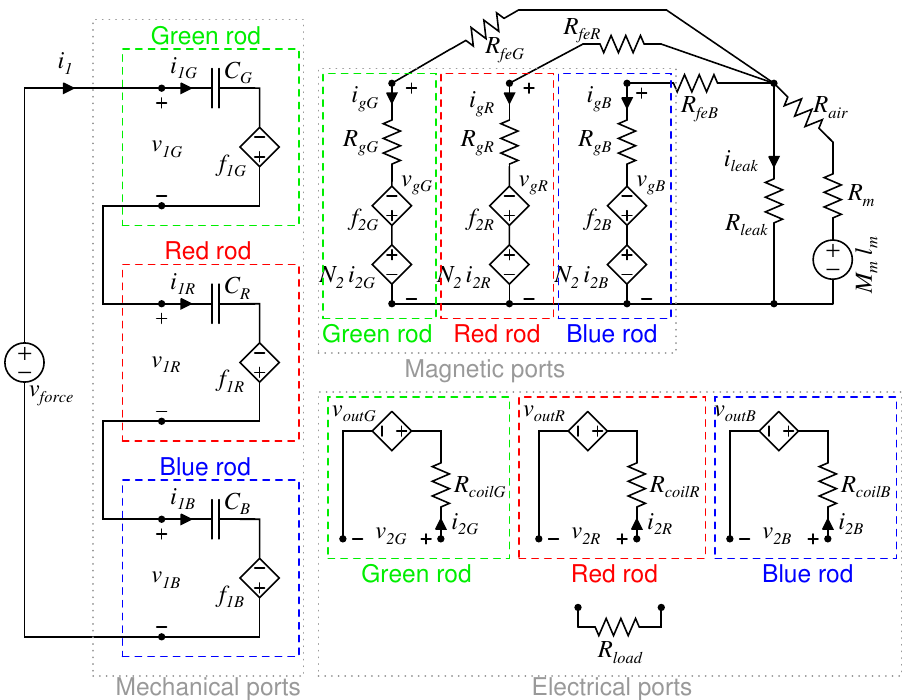
Figure 8. Equivalent three port nonlinear model circuit of the three-rods Galfenol KEH. The mechanical ports are connected in series because the universal testing machine (UTM) speed is the same for each rod, while the electrical ports can be connected together in series or parallel on a resistive